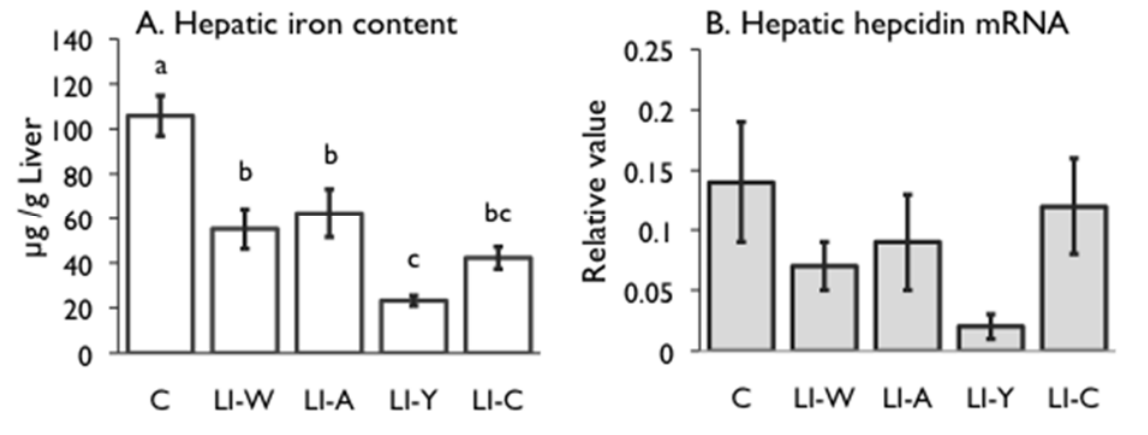
Figure 1. Total iron binding capacity ( A ); serum iron ( B ); transferrin saturation ( C ) on day 21, 26, 31, 36 and 42 after start of experimental period. Iron deficiency anemia rats, fed low iron diet for 21 days, divided four subgroups, was fed either an egg white diet (LI-W, n = 6), an ovalbumin diet (LI-A, n = 7), an egg york diet (LI-Y, n = 6) or a control diet (LI-C, n = 6) and normal rats fed the control diet (C, n = 6) for 42 days. Values were represented as mean. Values with an unlike letter were significant: p <